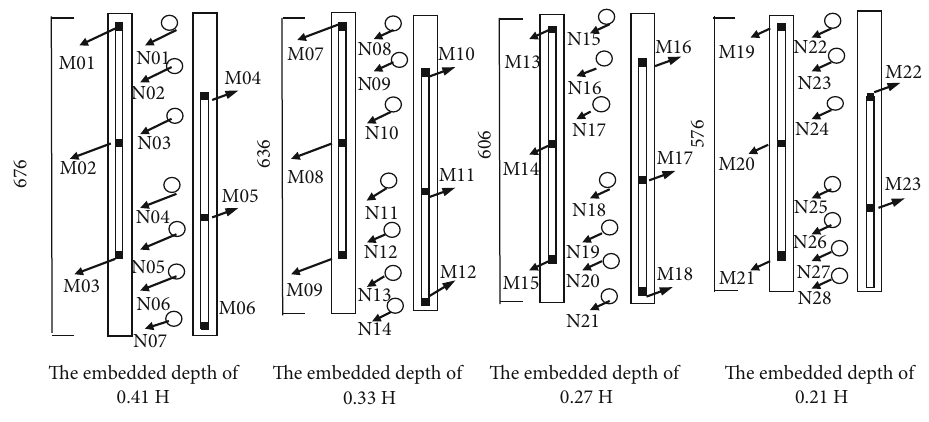
Figure 6: The location of the displacement sensor and earth pressure cell. Table 3: The steps of test preparation.